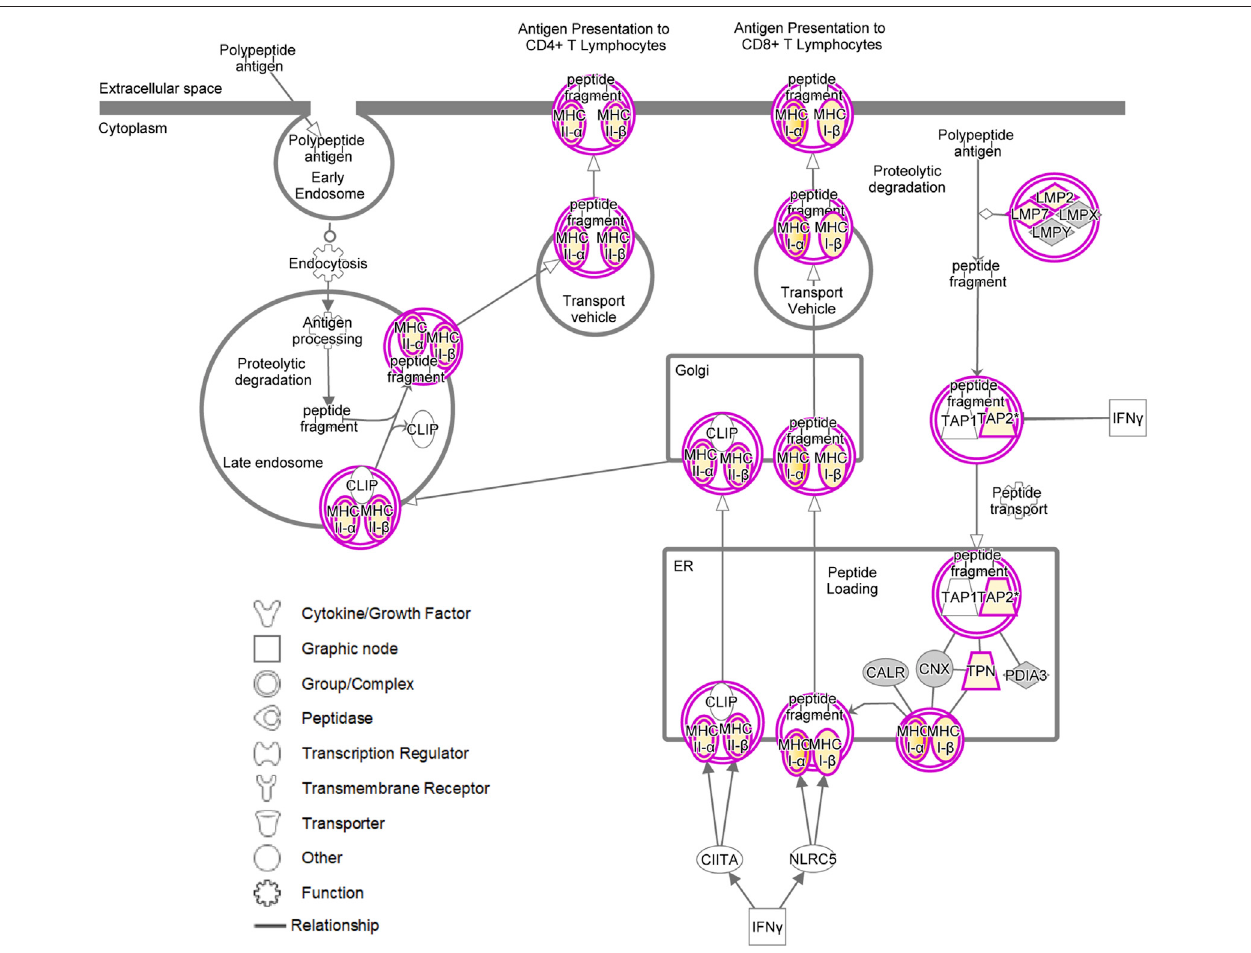
FIGURE7| IPAforpRMGcellsaftertreatmentwithIFN γ wasperformed.Depictedisthecanonicalantigenpresentationpathway.Yellowproteinsareinduced.The intensity of the yellow color indicates the degree of upregulation. Grey proteins are in the dataset but did not pass the analysis cutoffs of the pathway analysis. Purple circles highlight proteins (single circle) or complexes (double